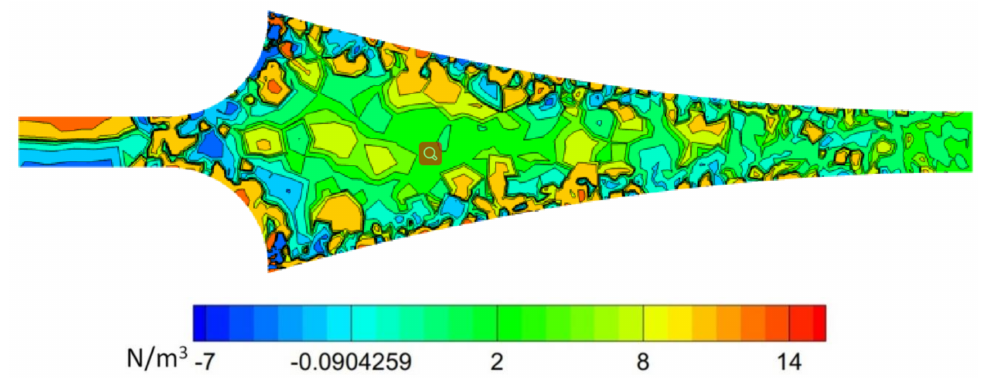
Figure 11. Distribution of electromagnetic body force when EOF is introduced in TRC